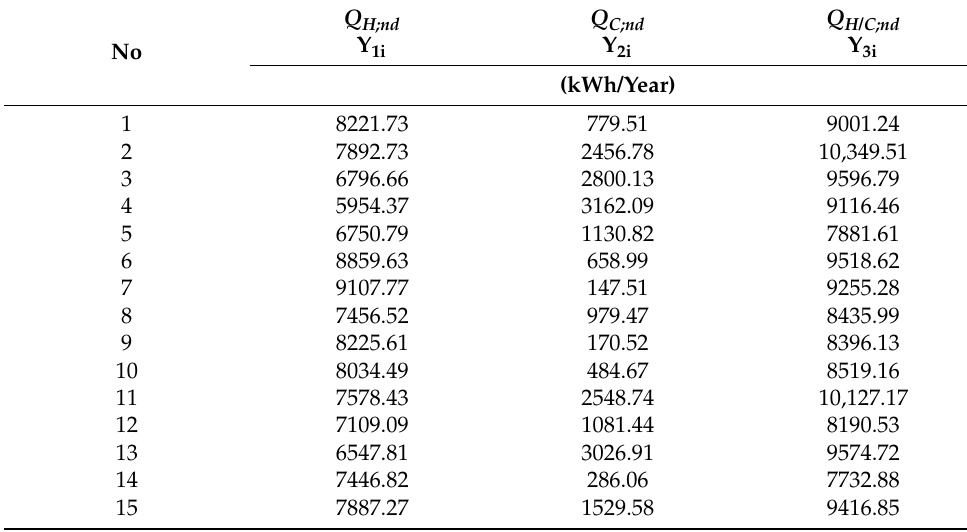
Table 3. Results of the simulation of the Q H,nd , Q C,nd , and Q H/C;nd in individual variants determined according to the design of the computational